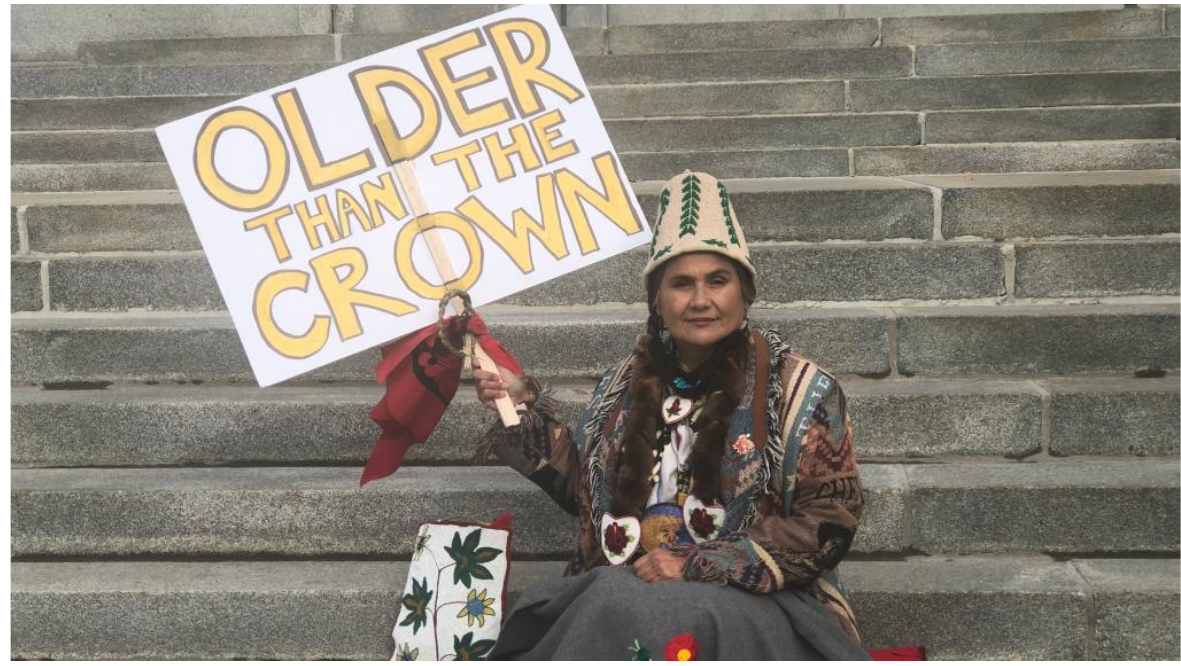
Figure 4: In this photo, S n ̓ʕ a y ̓ čkstx (Sinixt Arrow Lakes) Spokeswoman and cultural coordinator Shelly Boyd waits for a judgement on the steps of the Supreme Court of Canada building located in the country’s capital - Ottawa. The decision she waits for will either facilitate or deny her people hunting rights in Canada (CTV News 2021). Courtesy: Derrick